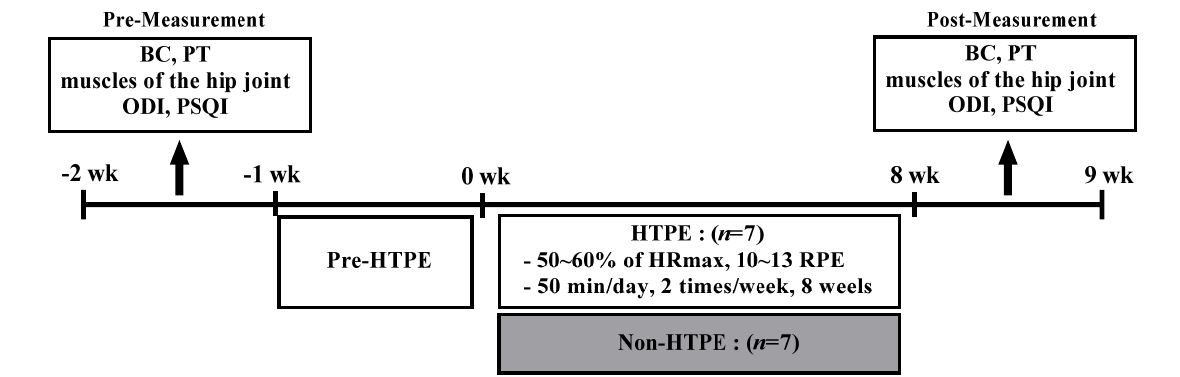
Figure 1. Experimental design. BC: body composition, PT: pelvic tilt, ODI: Oswestry Disability Index, PSQI: Pittsburgh Sleep Quality Index, HTPE: home-based tele-pilates exercise, HRmax: maximal heart rate, RPE: rating of perceived exertion